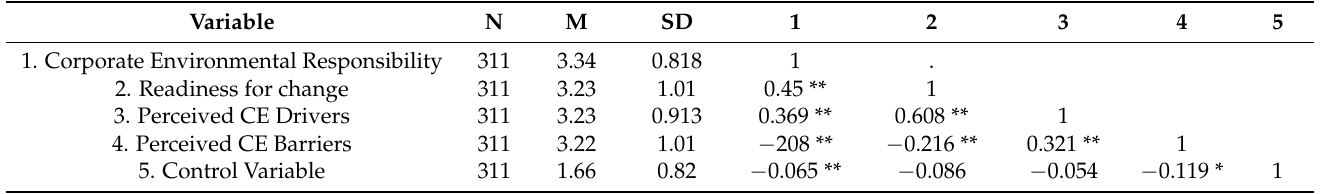
Table 2. Descriptive statistics and correlations for continuous